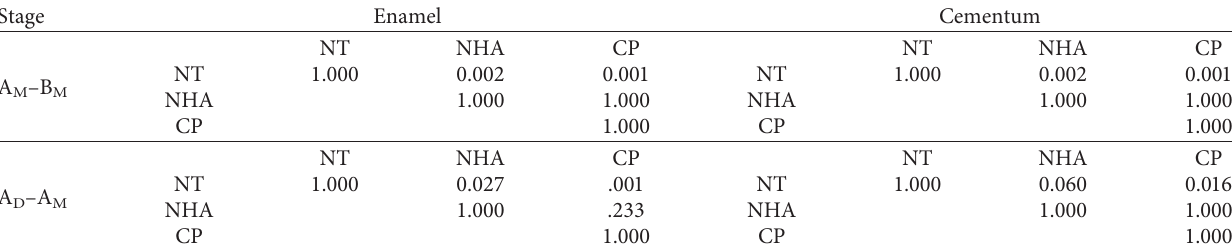
Table 3: Multiple comparisons of Vickers microhardness of enamel and cementum upon application of nanohydroxyapatite (NHA) and Clinpro (CP) compared with no treatment (NT) at different stages including before material application ( B M ), after material application ( A M ), and after inducing demineralization ( A D